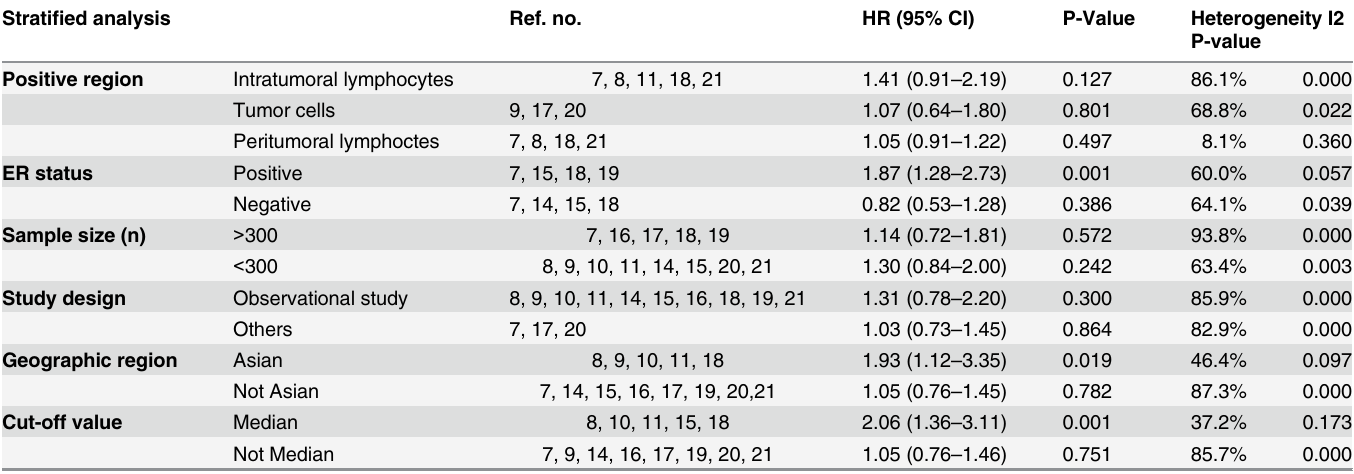
Table 5. Association between FOXP3 expression and OS stratified according to FOXP3-positive region, ER status, sample size, study design, geo- graphic region and the FOXP3-positive cut-off value. Strati fi ed analysis Ref. no. HR (95% CI)